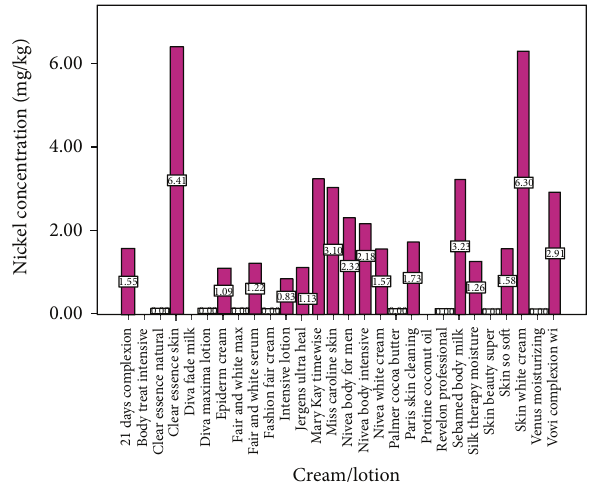
Figure 2: Nickel concentration in creams and